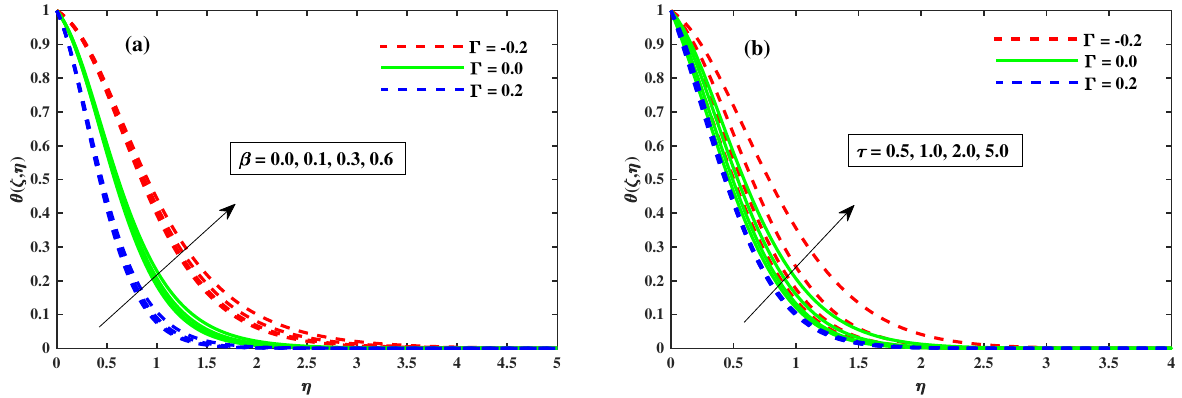
Figure 10. The variation of temperature against β in ( a ) and for τ in ( b